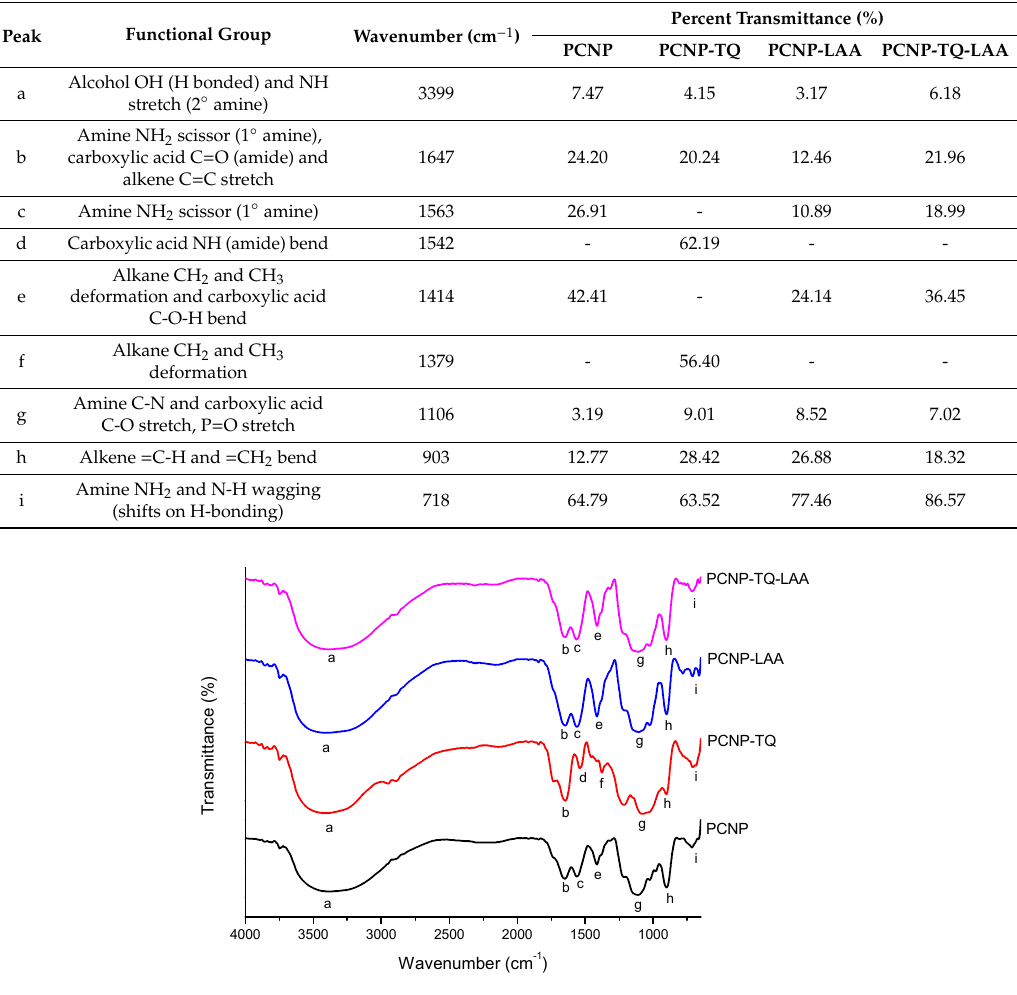
Table 2. Percent transmittance of functional groups existed in PCNP, PCNP-TQ, PCNP-LAA and PCNP-TQ-LAA.